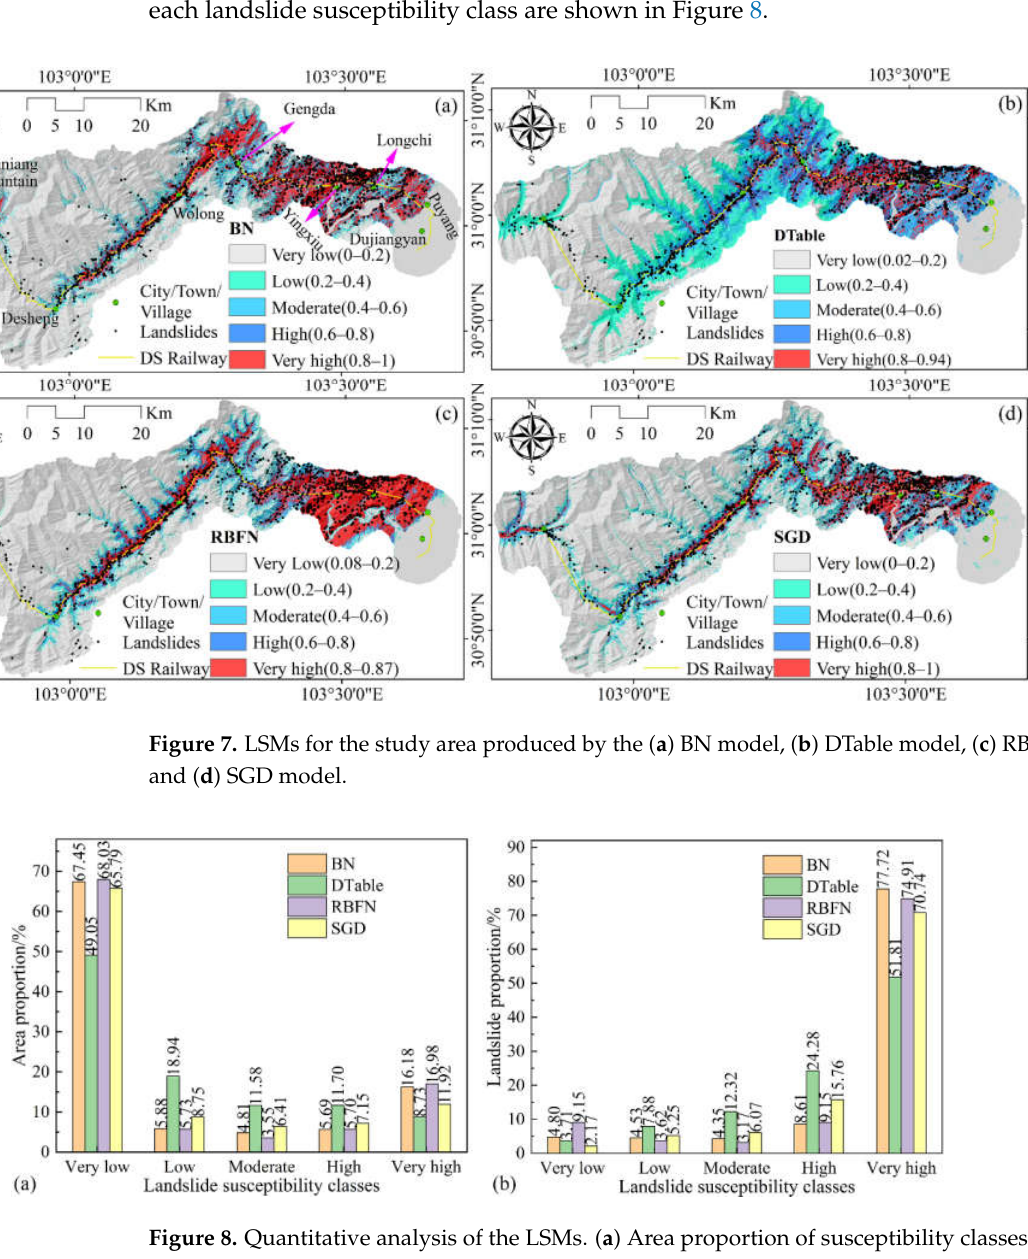
Figure 9. Frequency ratio of landslides within susceptibility classes. LSMs of the 1 km buffer zone along the proposed DS railway were extracted to ex- hibit the possible impact of landslides within a specific range along the railway (Figure 10). The buffer zone with an area of 245.87 km 2 involved 468 landslides, accounting for 42.39% of all landslides. According to the area proportion of landslide susceptibility clas- ses within the buffer zone (Figure 11a), we found that 47.11−58.32% of buffer zones are located in zones with high- and very high-susceptibility to landslides, while the very low zone only occupies 24.45−31.35% of the buffer zone. Obviously, the high- and very high-